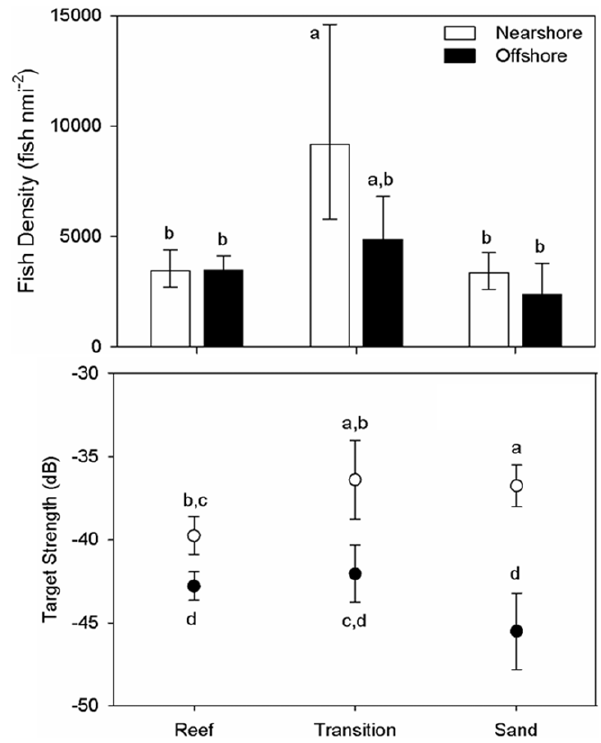
Figure 4. Least-square means estimates of acoustic fish density (fish nmi 2 2 ; upper panel) and mean acoustic target strength; lower panel) of fish at boulder/lava field (reef), sand, and transitional habitat surveyed off southwestern Iceland 15–16 April 2009 using a split beam echosounder with a 120 KHz 6 u split-beam digital transducer operating at 0.4 ms. Nearshore stations (white) and offshore (filled) stations are illustrated. Error bars represent upper and lower 90 th percentile confidence